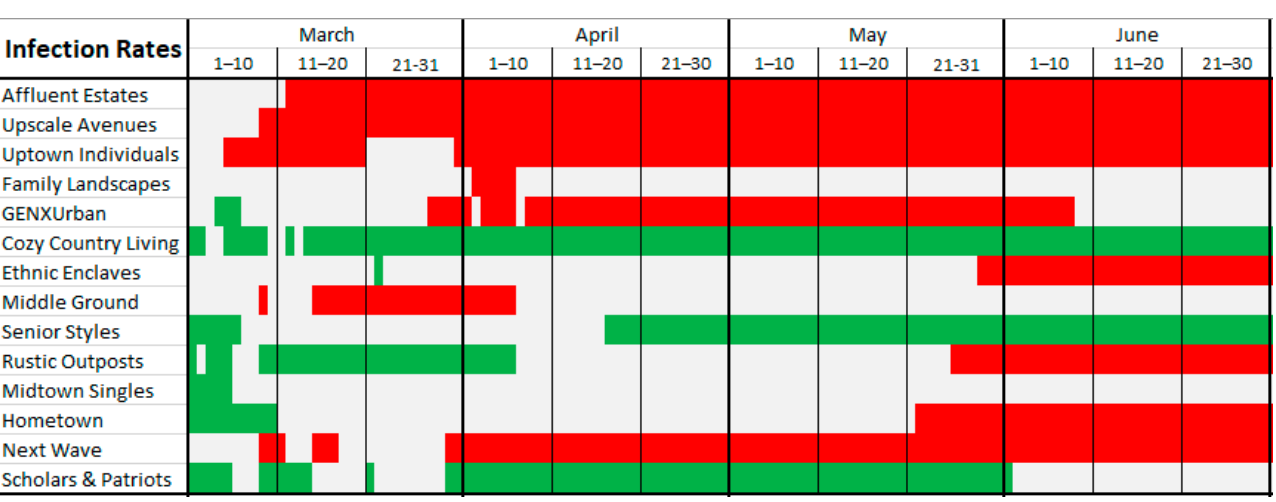
Figure 3. COVID-19 infection risk by LifeMode and date. Red color indicates high risk for that LifeMode and date; green color indicates low risk for that LifeMode and date; white color indicates inconclusive risk.